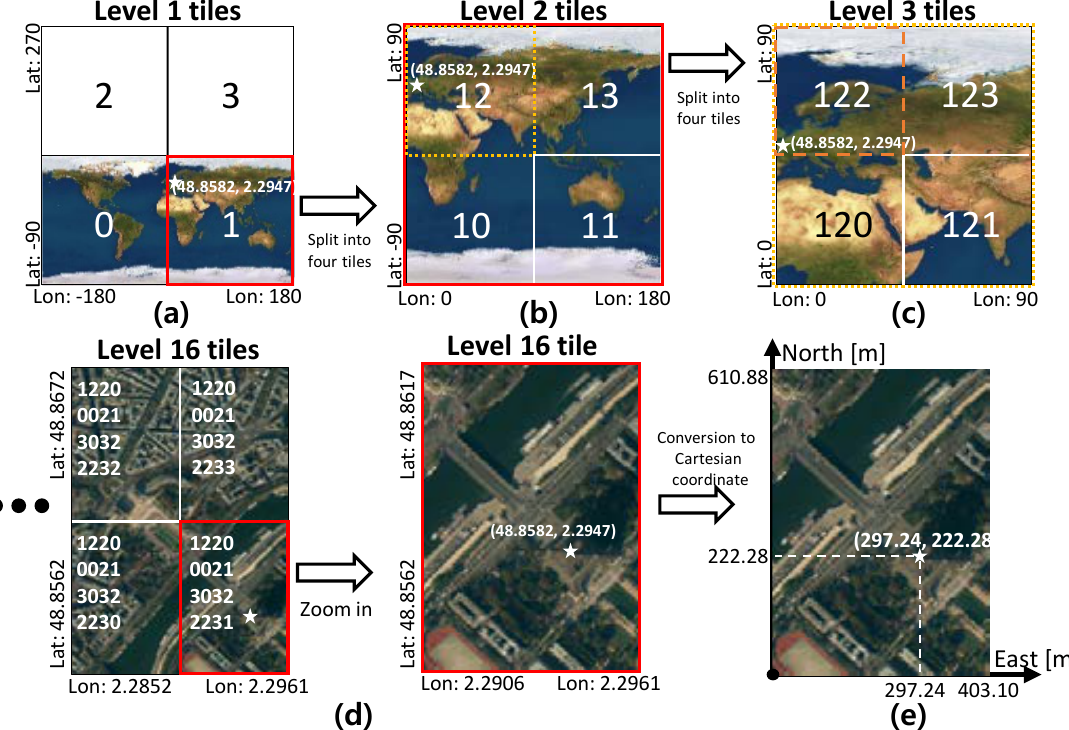
Figure 6. Geodetic quad-tree tile system for global EOGM management. tiles of level 1–16, and tile for global EOGM in Cartesian